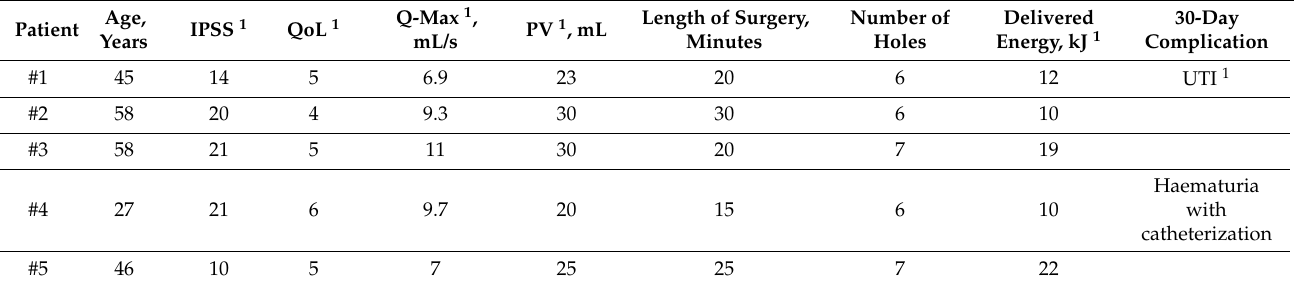
Table 5. Follow-up visits.